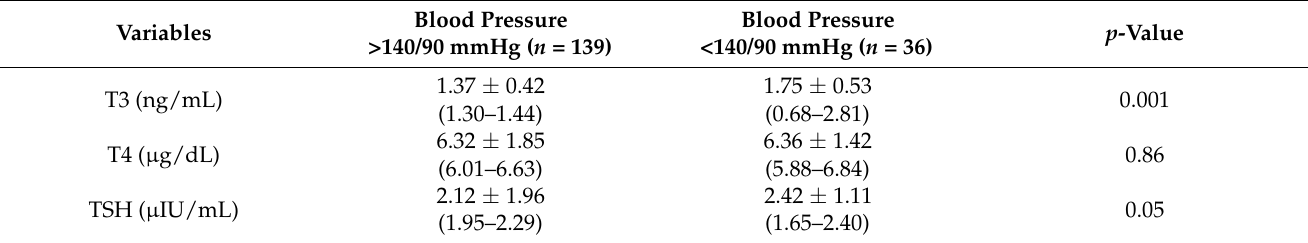
Table 5. Comparison of thyroid hormone levels among hypertensive pregnant women with Blood pressure greater than 140/90 mmHg and less than 140/90 mmHg.